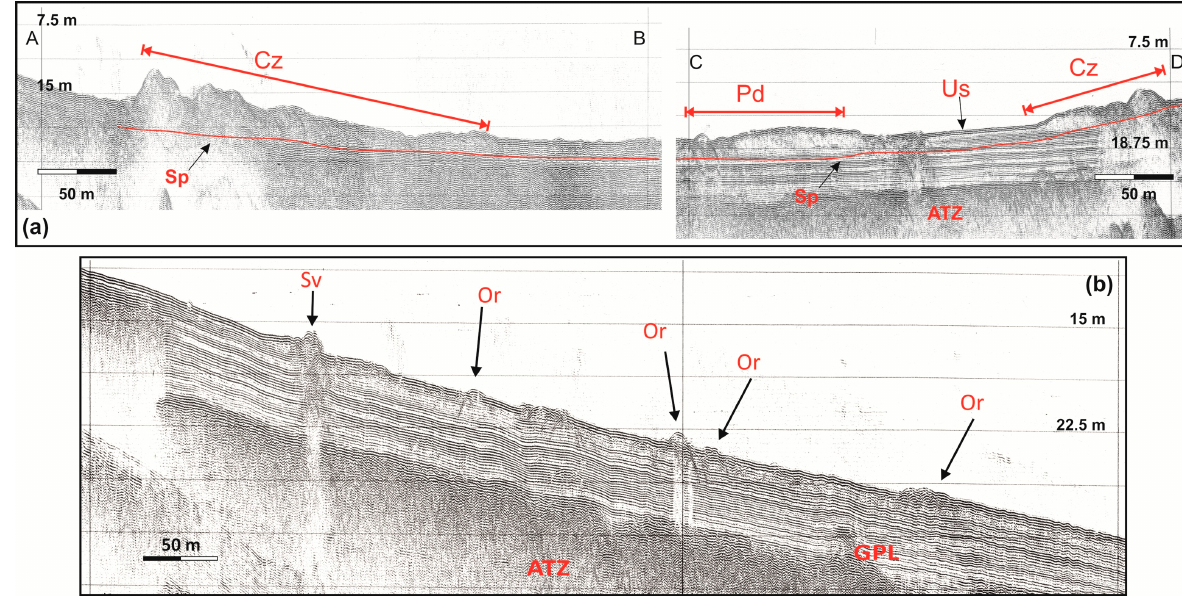
Figure 6. ( a ) Seismic profiles in the strike direction showing the slide plane all over the area and slid masses with different styles of deformation during transport; (Cz): compressional zone, (Pd): slide deposits that have undergone plastic deformation, (Us): undisturbed sediments, (Sp): Slip plane, (ATZ): Acoustic turbid zone; ( b ) Seismic profile in the dip direction showing the presence of gas below the surficial sediments as indicated by the acoustic turbid zone (ATZ) and gas plumes (GPL). The disruption of the stratified surficial reflections by piercement like feature indicate the presence of sand volcano (Sv) formed by the expulsion of water and gas induced by the earthquake. (Or): Out-runners. For the seismic profiles location see Figure 3.